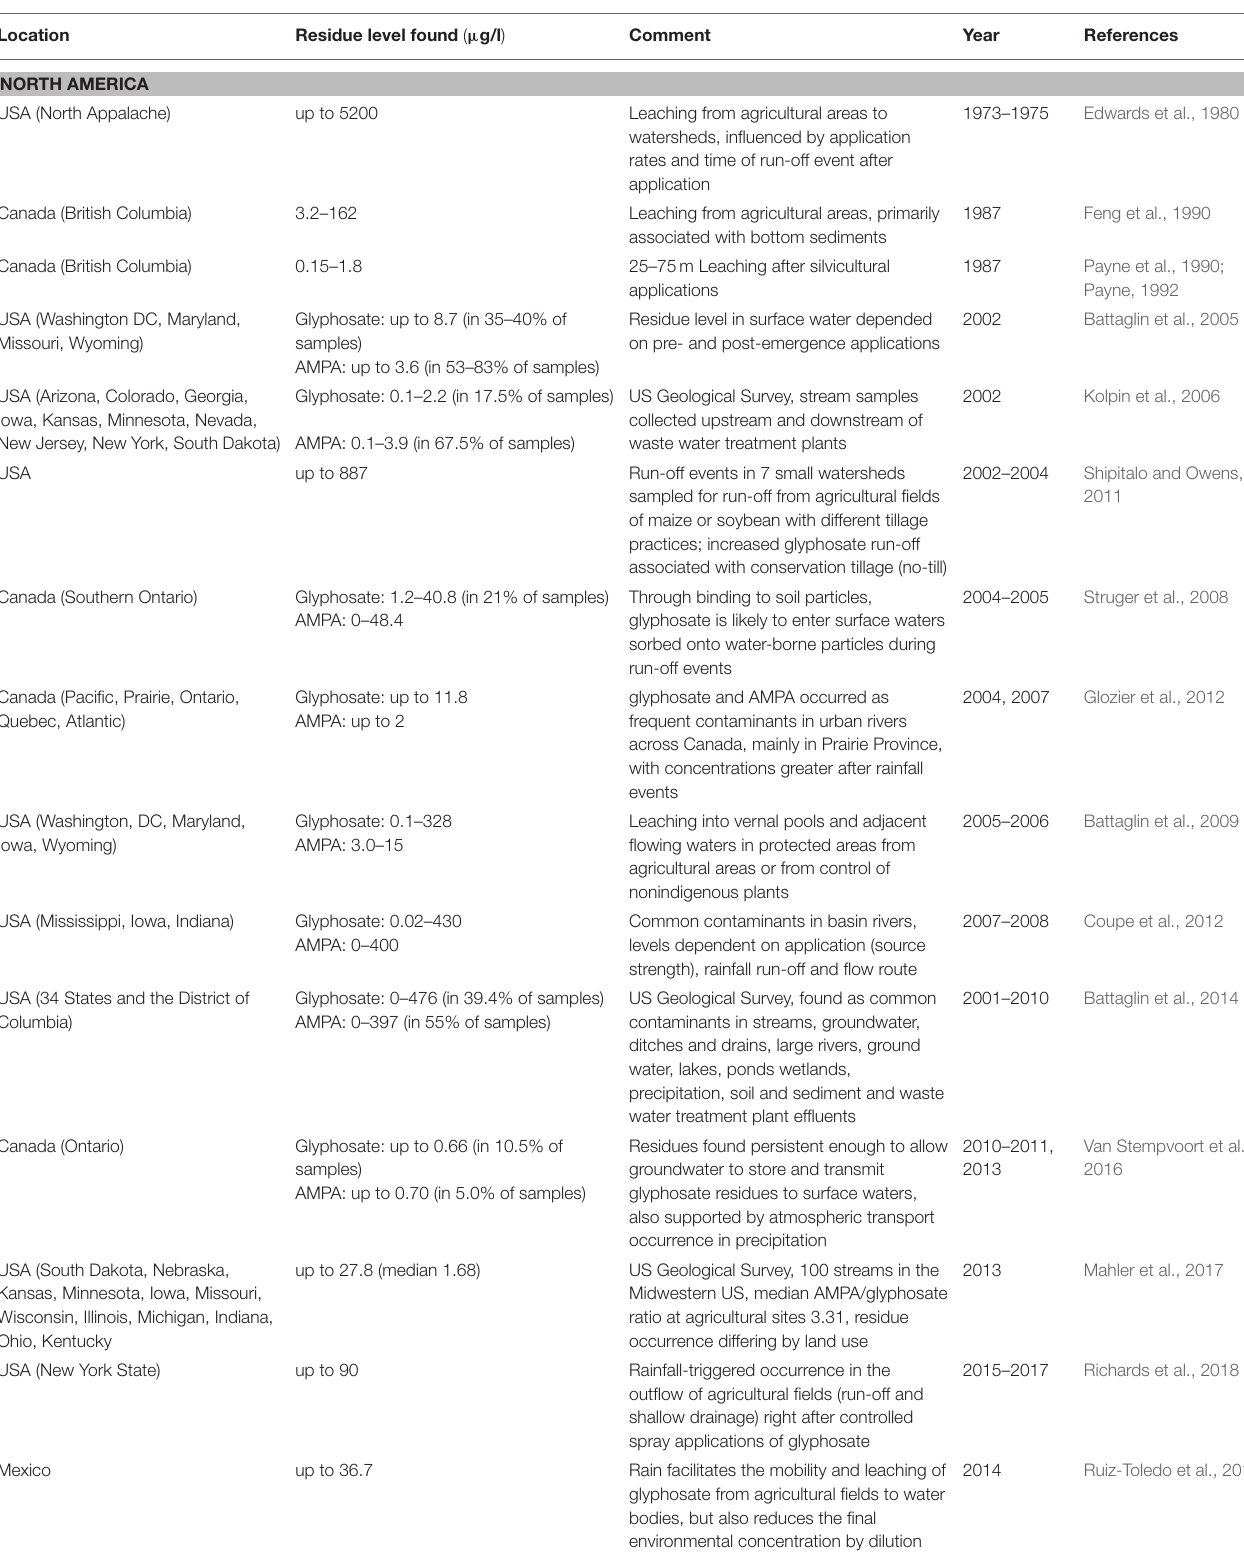
TABLE 3 | Glyphosate residues found in surface and ground water in selected environmental monitoring studies.